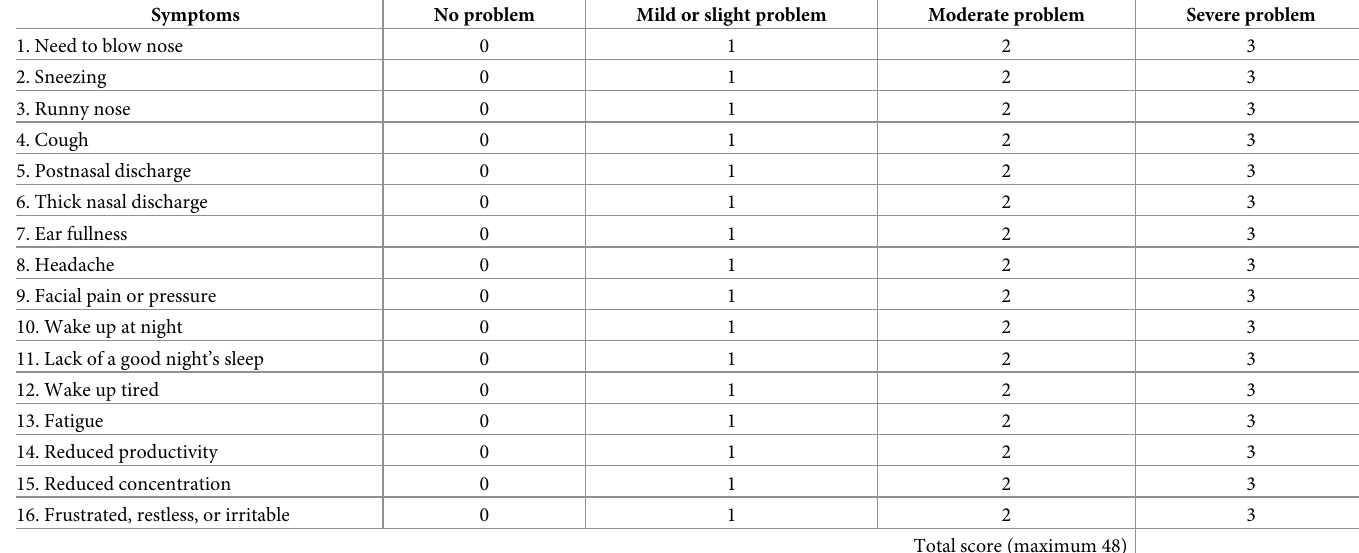
Table 1. SNOT-16 questionnaire [17,28] . Rate how much you have been bothered, in terms of severity and frequency, by the following symptoms.